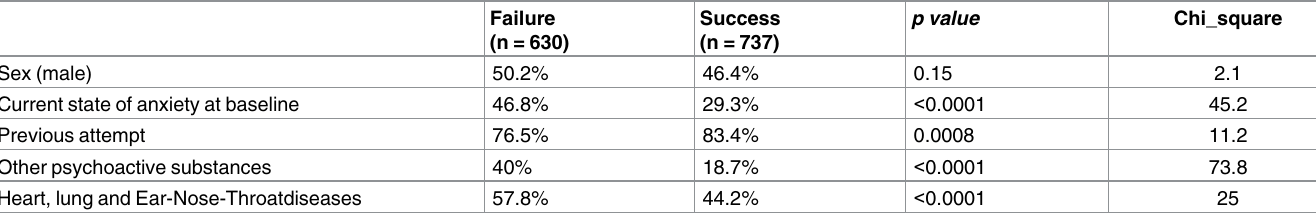
Table 1. Frequencies (at the initial consultation) according to abstinence.